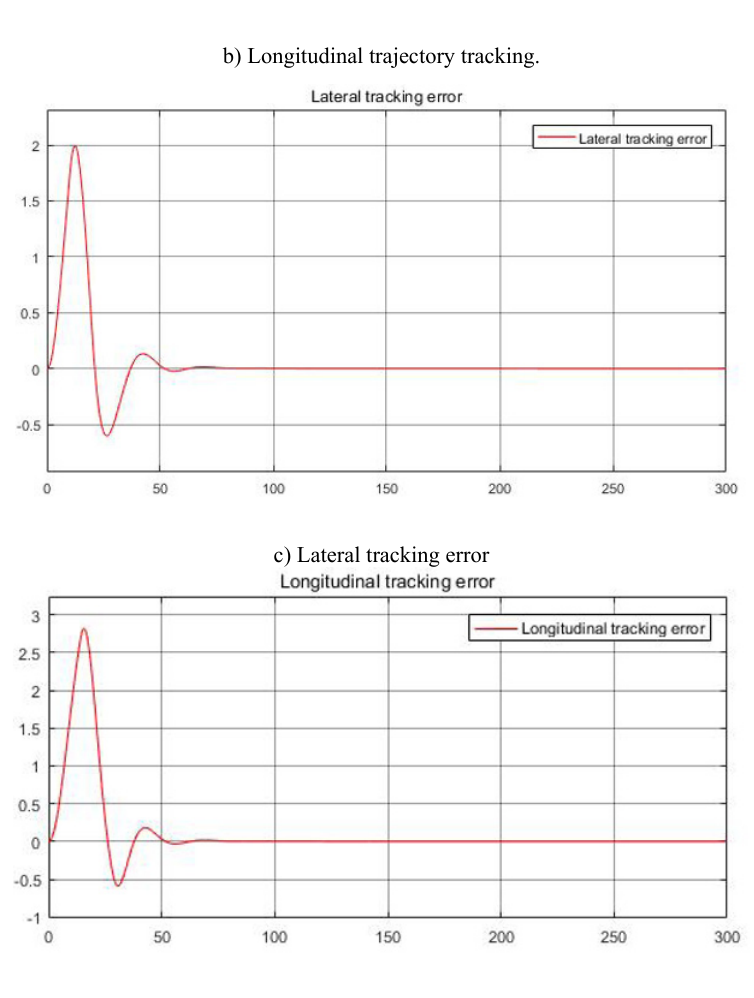
Fig. 5. First-order system for UAV trajectory